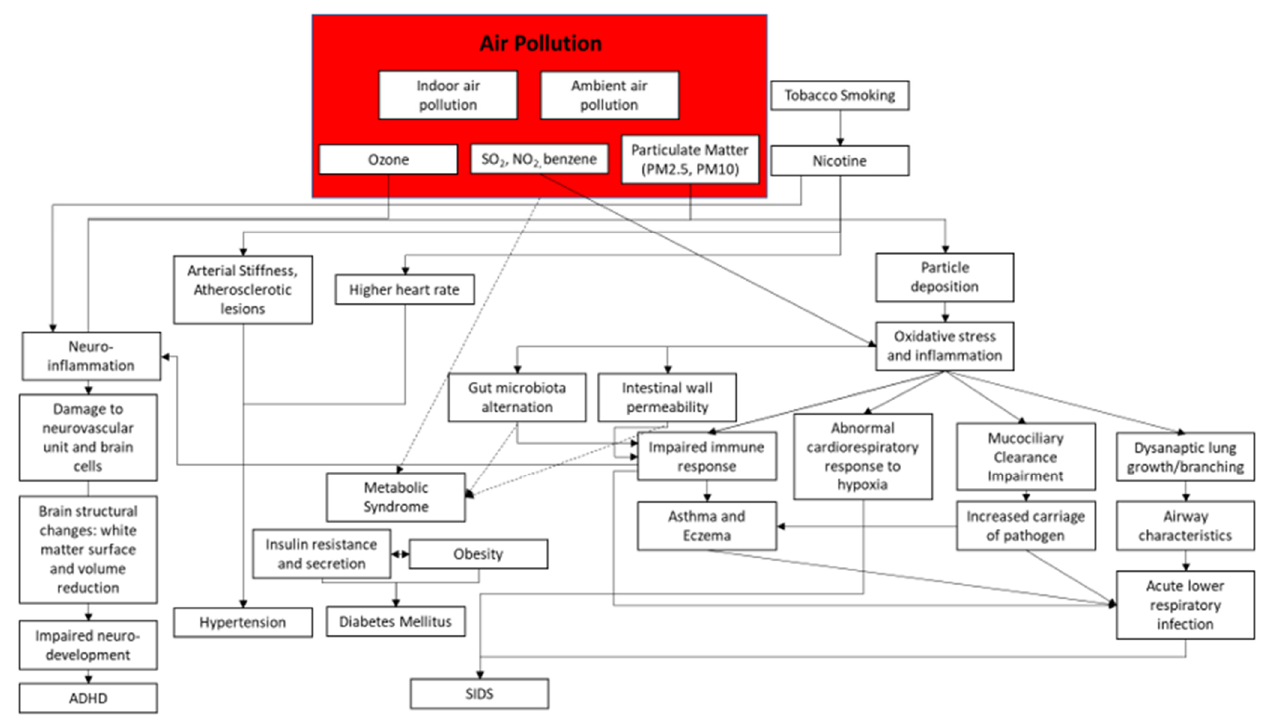
Figure 3. Theoretical framework of the impact of air pollution. (Note: = weak evidence; = strong or moderate evidence; SIDS = sudden infant death syndrome; ADHD = attention deficit hyperactivity disorder; PM = particulate matter).